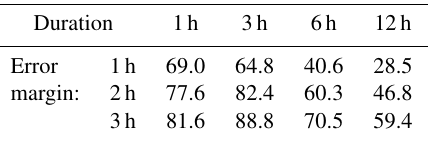
Table 3. Relative increase (%) of the hit rate (values in columns “same cat.” in Table 1) when allowing a temporal error margin be- tween 1 and